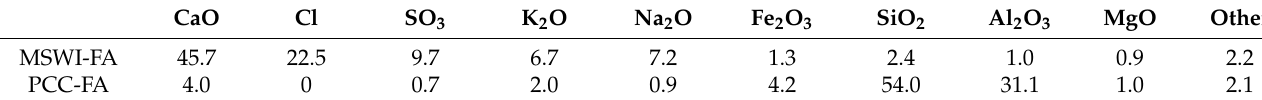
Table 1. Major elements of MSWI fly ash (MSWI-FA) and pulverized coal combustion fly ash (PCC- FA). Unit: %.